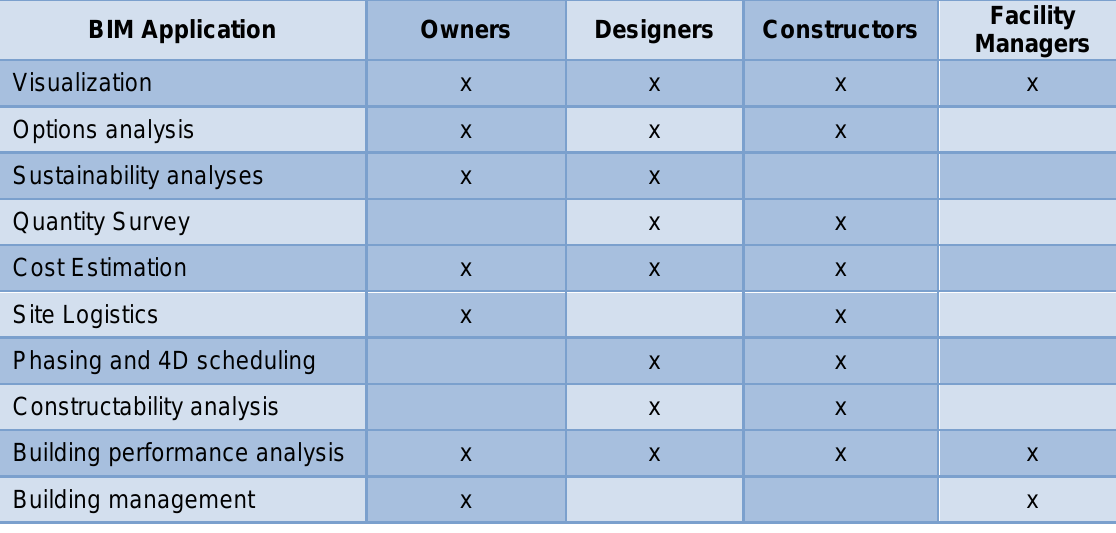
Table 2 BIM applications for project stakeholders Project